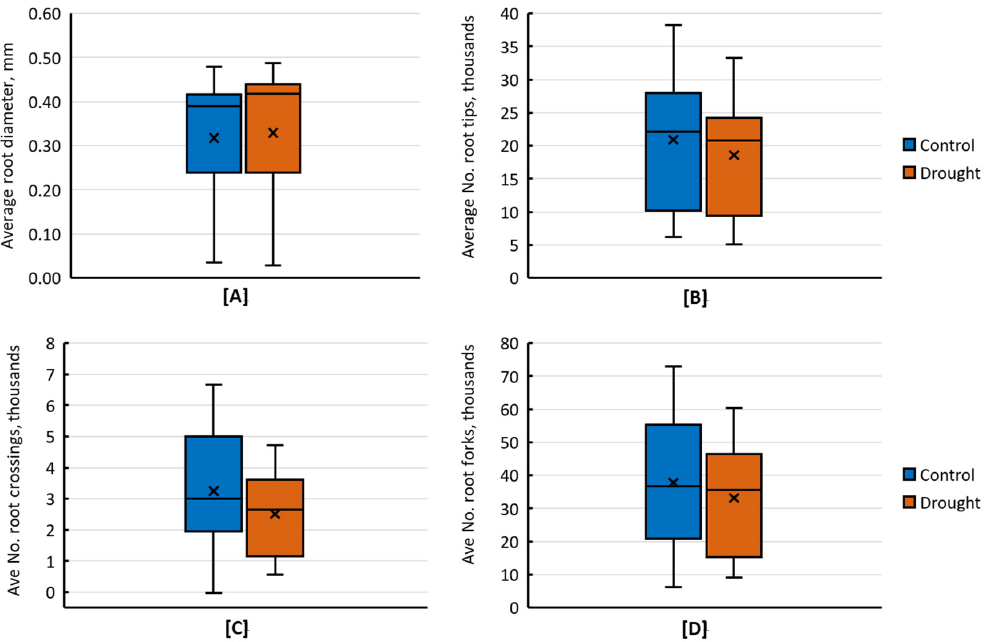
Figure 2. Box and whisker plots for root growth and developmental traits showing natural variation and the effect of drought treatment on the average ( A ) root diameter, mm plant − 1 , ( B ) number of root crossings, ( C ) number of root tips, and ( D ) number of root forks. The whisker below the box represents the first quartile (Q1) or the fifth percentile showing the first 25% data distribution in this range. In contrast, the whisker above the box represents the third quartile (Q3) or 95th percentile showing the last 25% of the data distribution. The length of the box is called the interquartile range (IQR) or (25th to 75th percentile), shows 25% to 75% of the data distribution for that particular trait, and the horizontal line in the box indicates the median value.